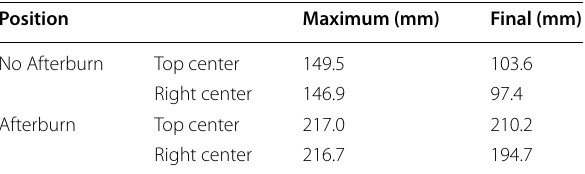
Table 6 Displacement